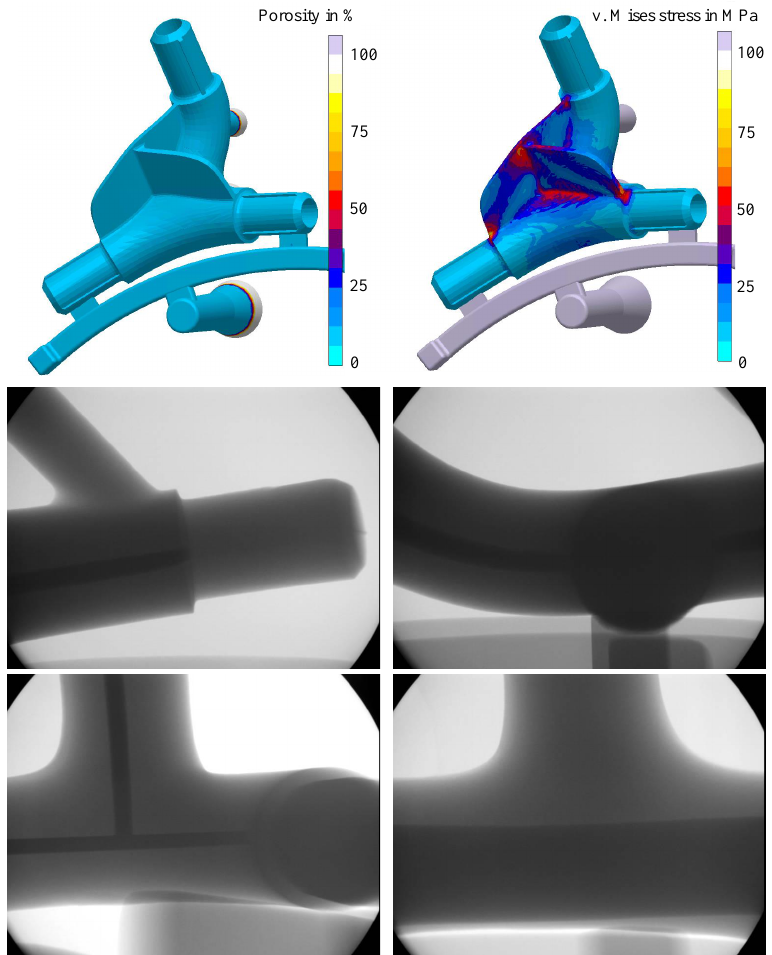
Figure 3. The upper row shows the numerical analysis of the casting process and residual stresses of a sample knot. The lower rows presents the results of X -ray measurements of a sample knot in order to control for pores in the